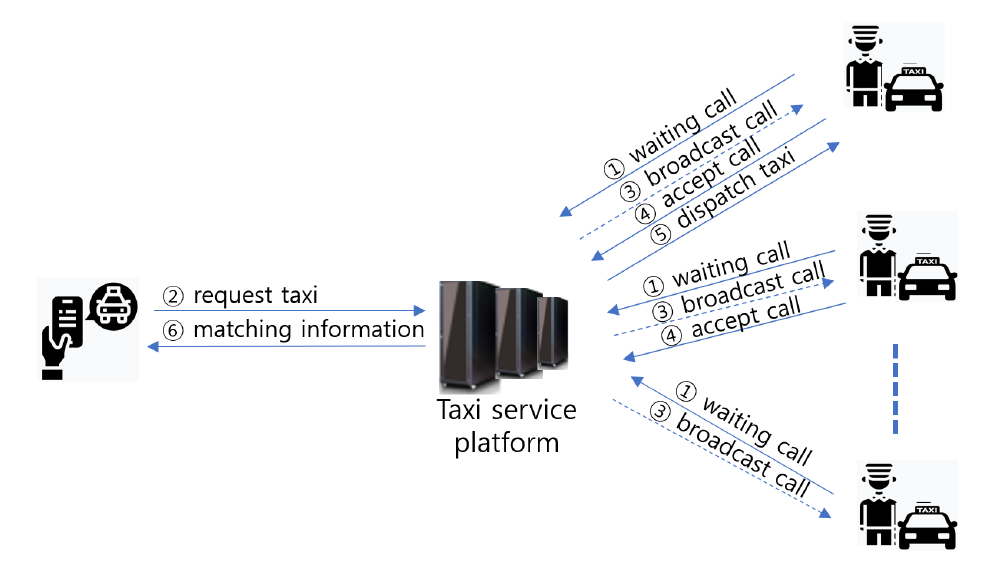
Figure 5. Dispatching flow of the taxi